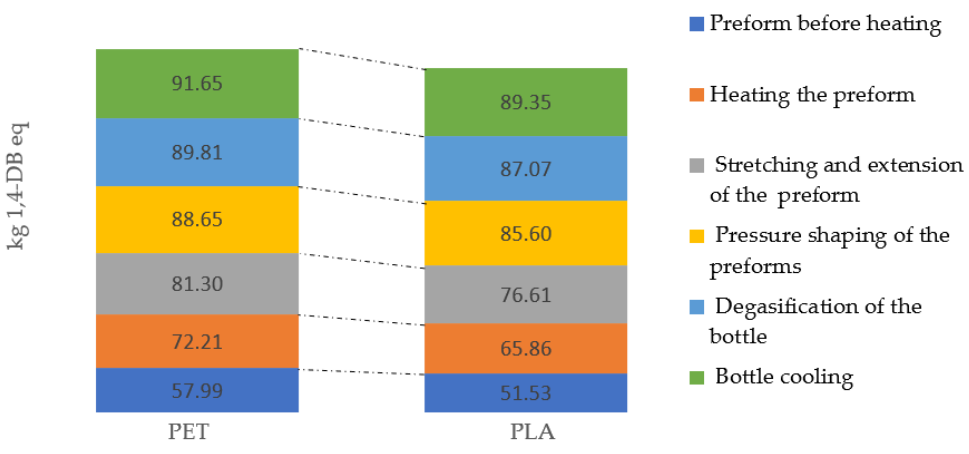
Figure 11. Marine aquatic ecotoxicity emissions throughout the entire bottle shaping process.